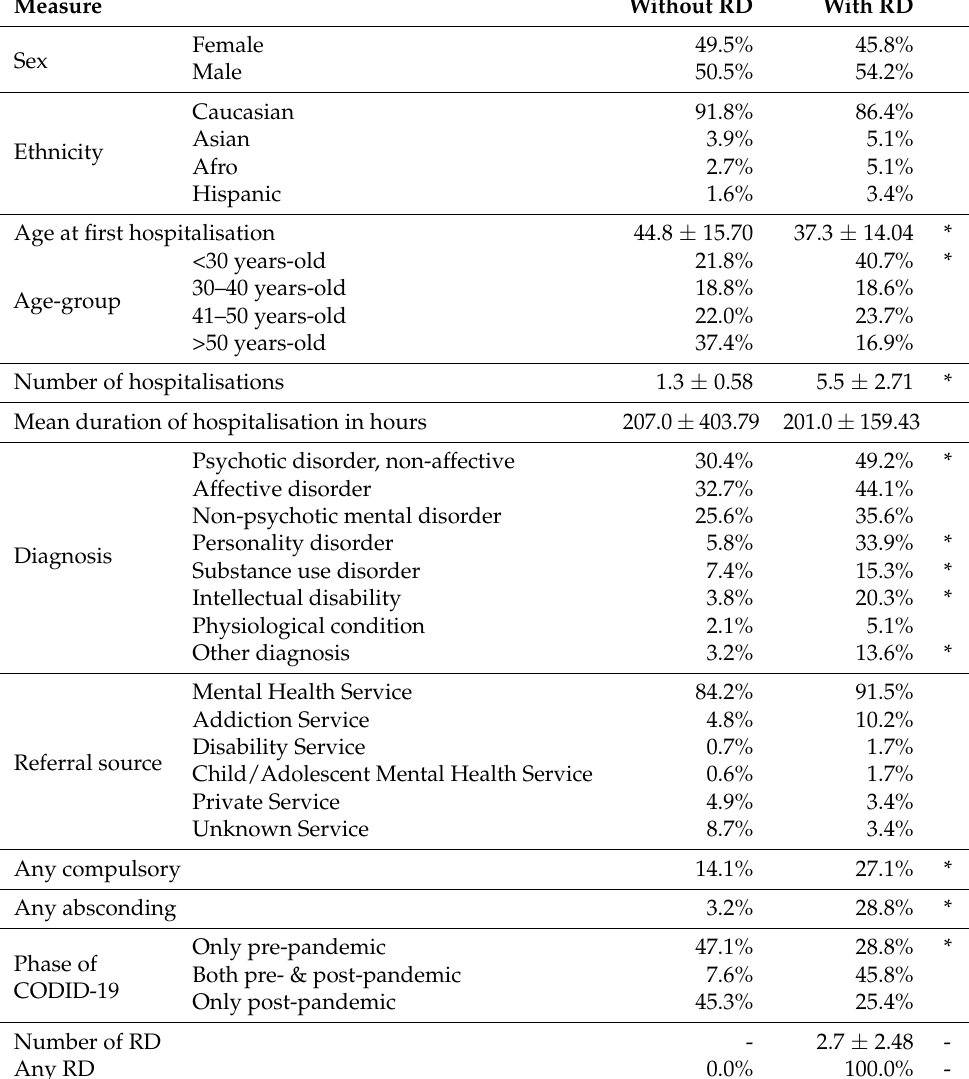
Table 1. Description of participants (N =